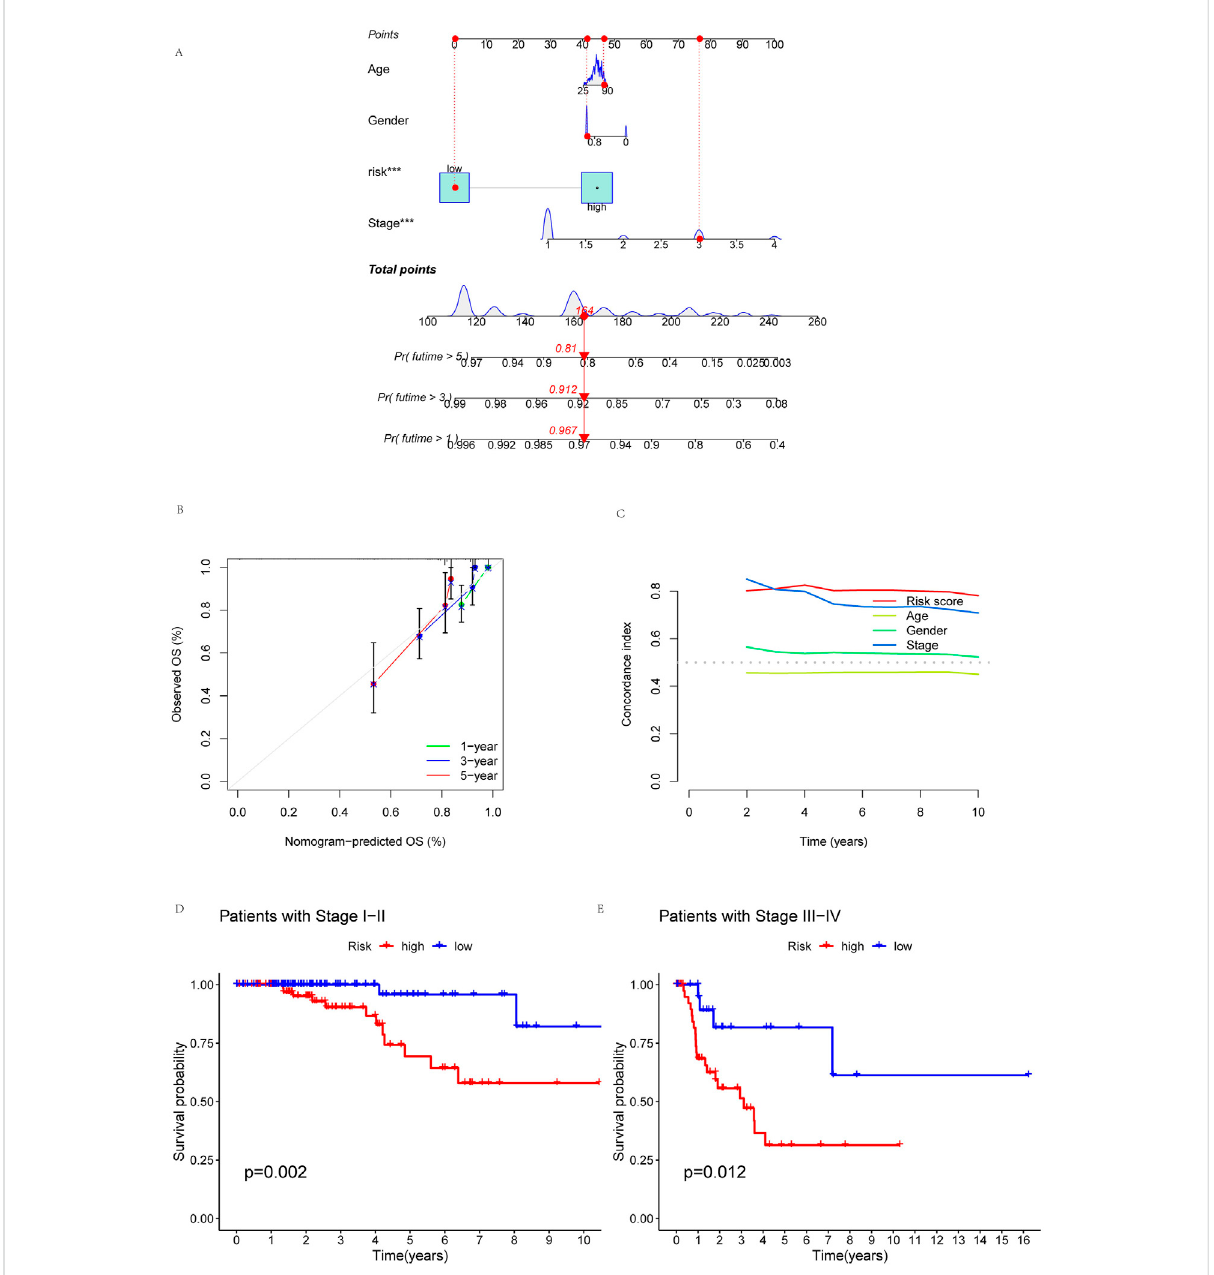
FIGURE 6 Building nomogram. Nomogram and clinical subgroups for predicting KIRP outcomes. (A) Nomogram to predict the OS in KIRP. (B) Calibration curves for1,3, and5 years. (C) C-index curveanalyzedtheconcordanceindexoftheriskscore.Patients weregrouped to seeifthemodelappliedto KIRP patients at (D) stages I-II and (E)